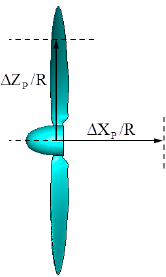
Figure 8. Axial and radial positions of an isolated propeller.